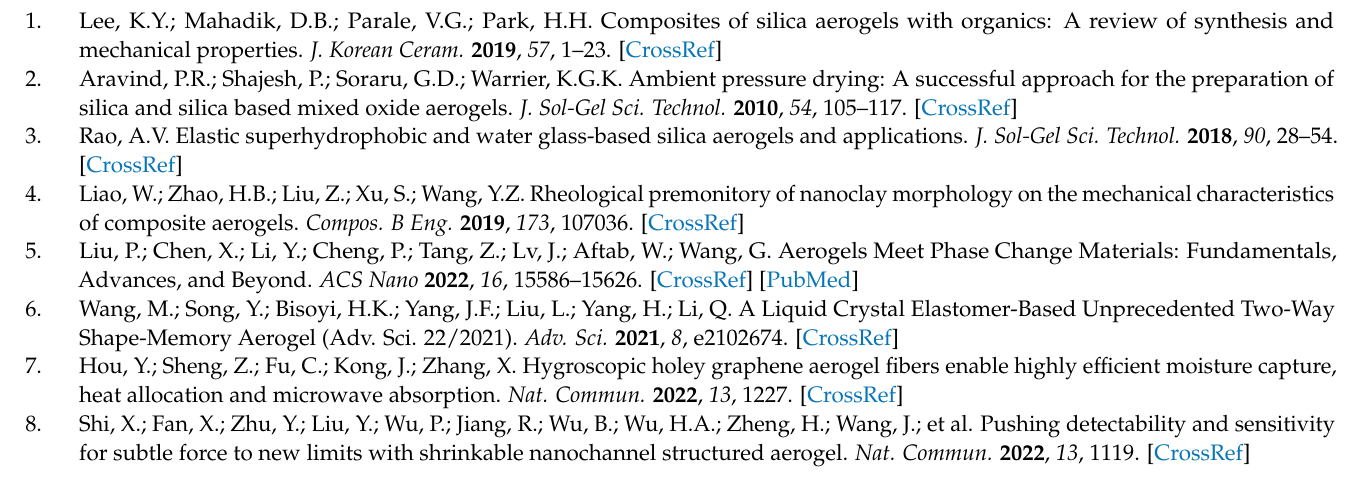
Figure S2: size distribution of silica sol microdroplets; Figure S3: optical images of the silica wet gel microspheres; Figure S4: size distribution of silica wet gel microspheres; Figure S5: size distribution of silica aerogel microspheres; Figure S6: adsorption–desorption isotherms of silica aerogel microspheres; Figure S7: FTIR spectra curves of aerogel specimens; Table S1: physical properties of silica aerogel microspheres